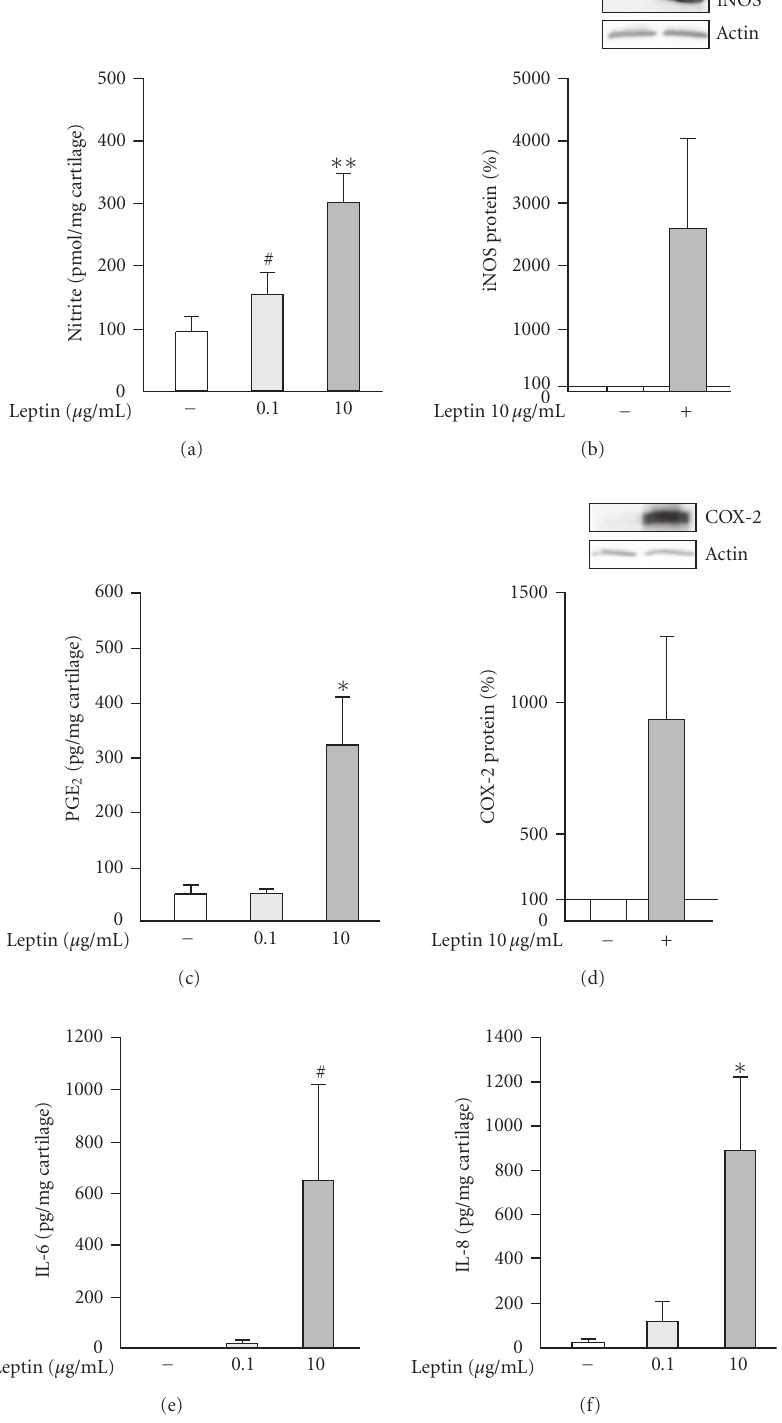
Figure 1: The e ff ect of leptin on NO production (a), iNOS protein expression (b), PGE 2 production (c), COX-2 protein expression (d), IL-6 production (e), and IL-8 production (f) in human OA cartilage. Cartilage explants were incubated with leptin (0.1 μ g/mL or 10 μ g/mL) for 48 hours. NO production (a) was measured as nitrite accumulation in the culture medium by Griess reaction. Expression of iNOS protein (b) and COX-2 protein (d) were measured by Western blot. PGE 2 production (c) in the culture medium was measured by RIA. Concentrations of IL-6 (e), and IL-8 (f) in the culture medium were measured by ELISA. Results are expressed as pmol/mg cartilage (a), as percentages in comparison with control sample ((b) and (d)) or pg/mg cartilage ((c), (e), and (f)). Values are mean ± SEM. Samples were collected from 6 patients ( n = 6) in (a) and (c), from 3 patients ( n = 3) in (b) and (d), and from 7 patients ( n = 7) in (e) and (f). #: P < . 2, ∗ : P < . 05, and ∗∗ : P < . 01 as compared to control explants incubated in absence of exogenous